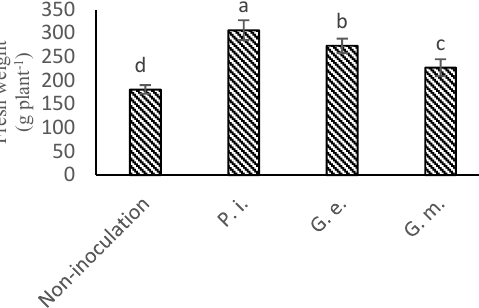
Figure 2. The mean effect of P. indica , G. etunicatum , and G. mosseae in lettuce plant fresh weight. (The means refer to four repetitions ± SD. Different letters for each parameter indicate significant differences assessed ( p < 0.05).)